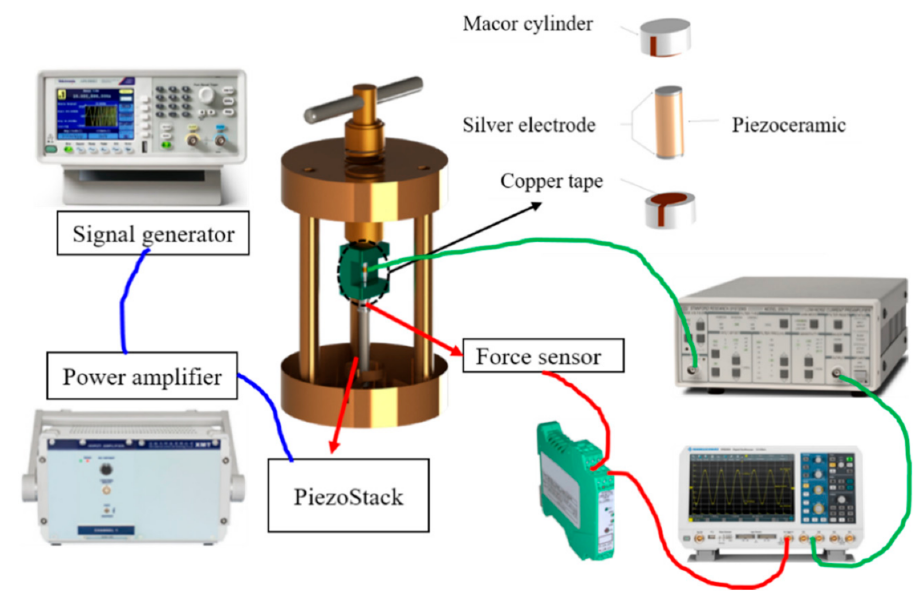
Figure 2. Configuration of the experimental platform.